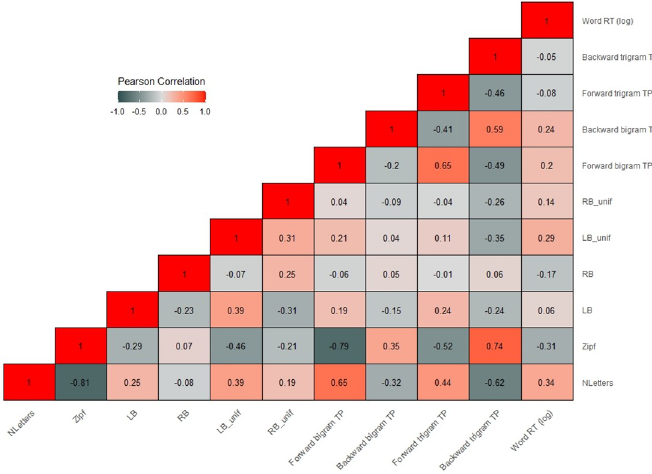
Fig 3. Heatmap showing the Pearson correlations between all word-level predictors and word RTs. Note: The TP measures contained some missing values, as by definition, the first word of a sentence is not defined in bigrams and the first two words are not defined in trigrams. Hence, bigram and trigram measures did not contain values for the first (and second) word(s) of each